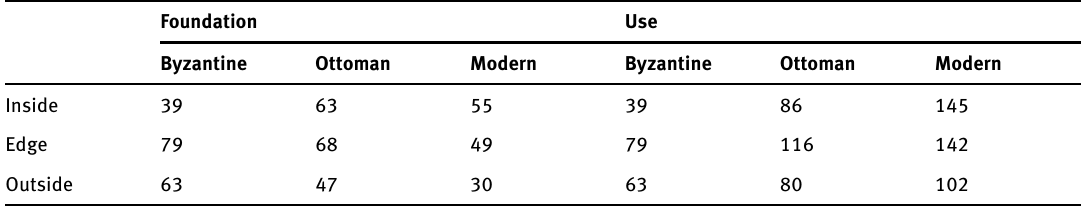
Table 2. Contingency Tables for Church Chronology and